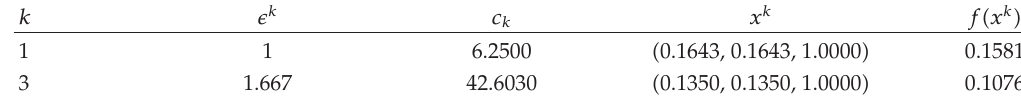
Table 2: Result of Example